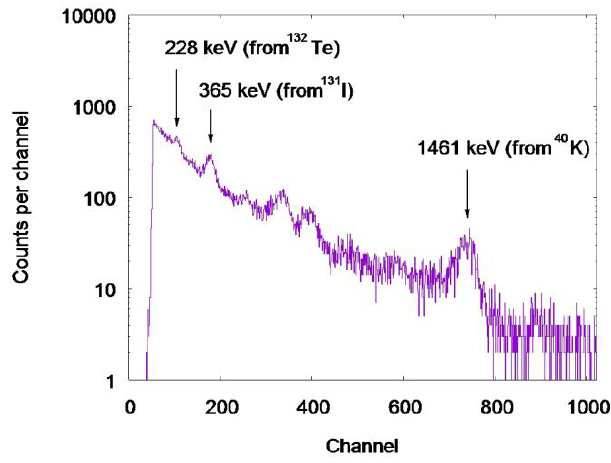
Figure 4. The gamma ray spectrum of the 53-old-year man, acquisition time = 5 min.